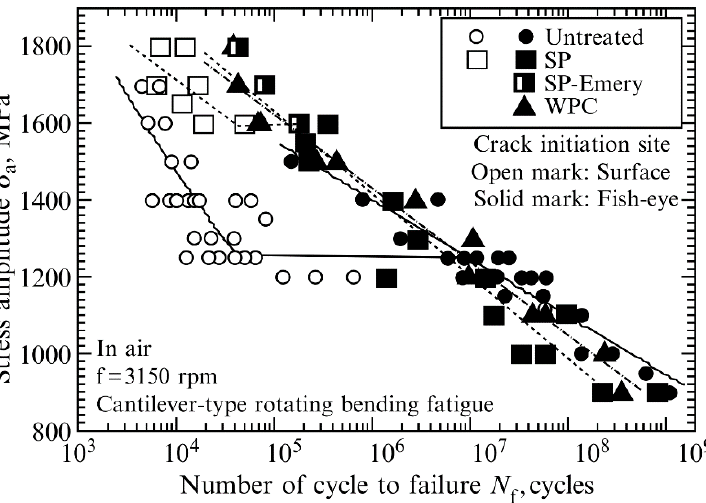
Figure 6. Comparison of rotary bending fatigue test results for different batches of JIS SUJ2 specimens. The specimens treated with 500 µm shot peening are marked as SP, and specimens treated with 55 µm fine particle shot peening (also known as the WPC treatment) are marked as WPC. The SP-Emery specimens were fabricated by post-polishing SP specimens. Reprinted with permission from Ref. [10]. Copyright 2002 Wiley.